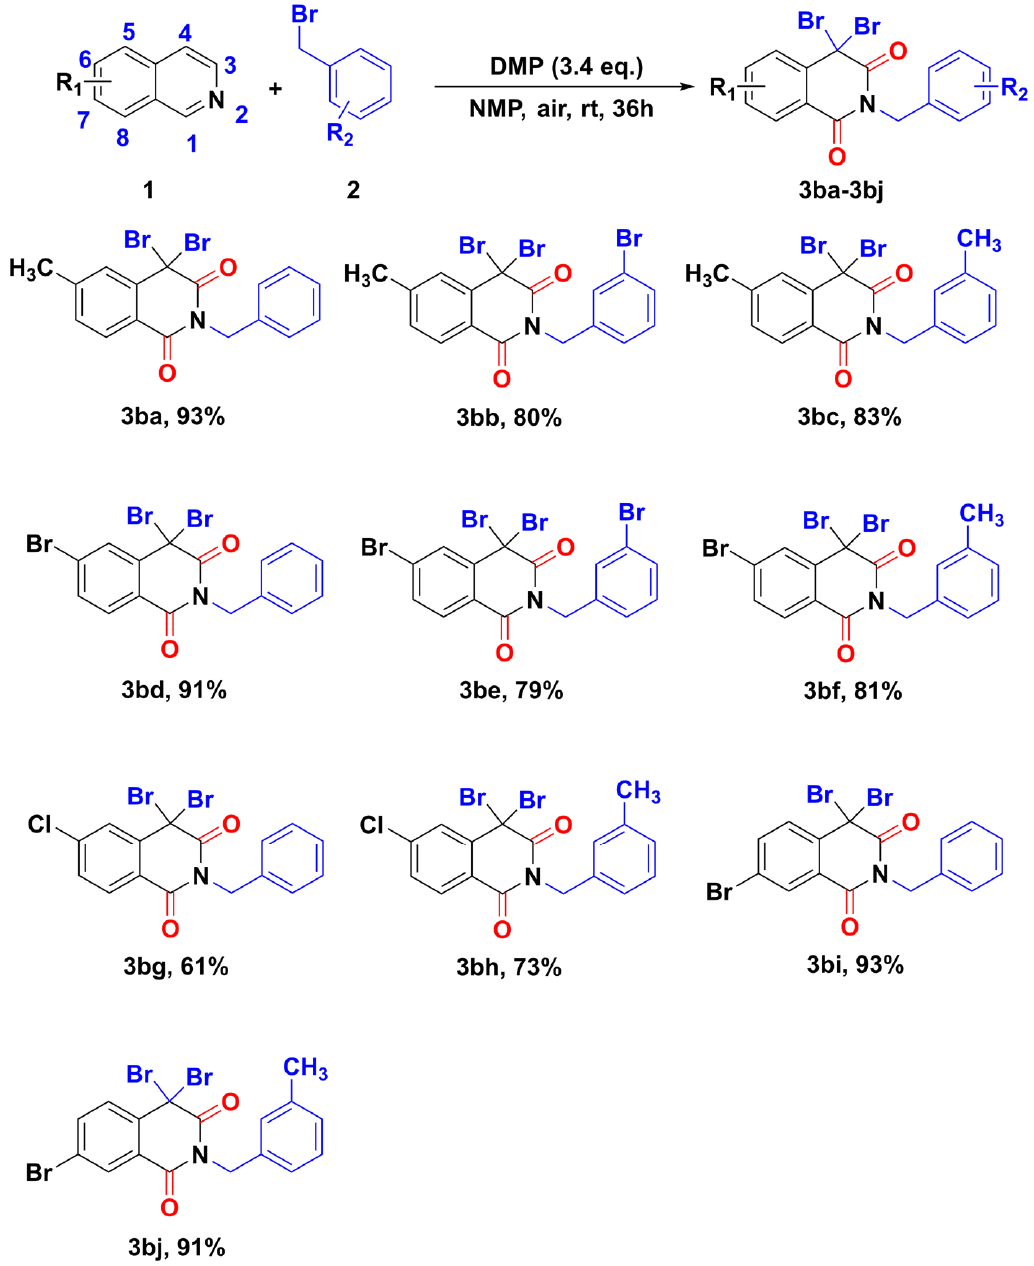
Figure 5. Substrate scope for isoquinoline counterpart.